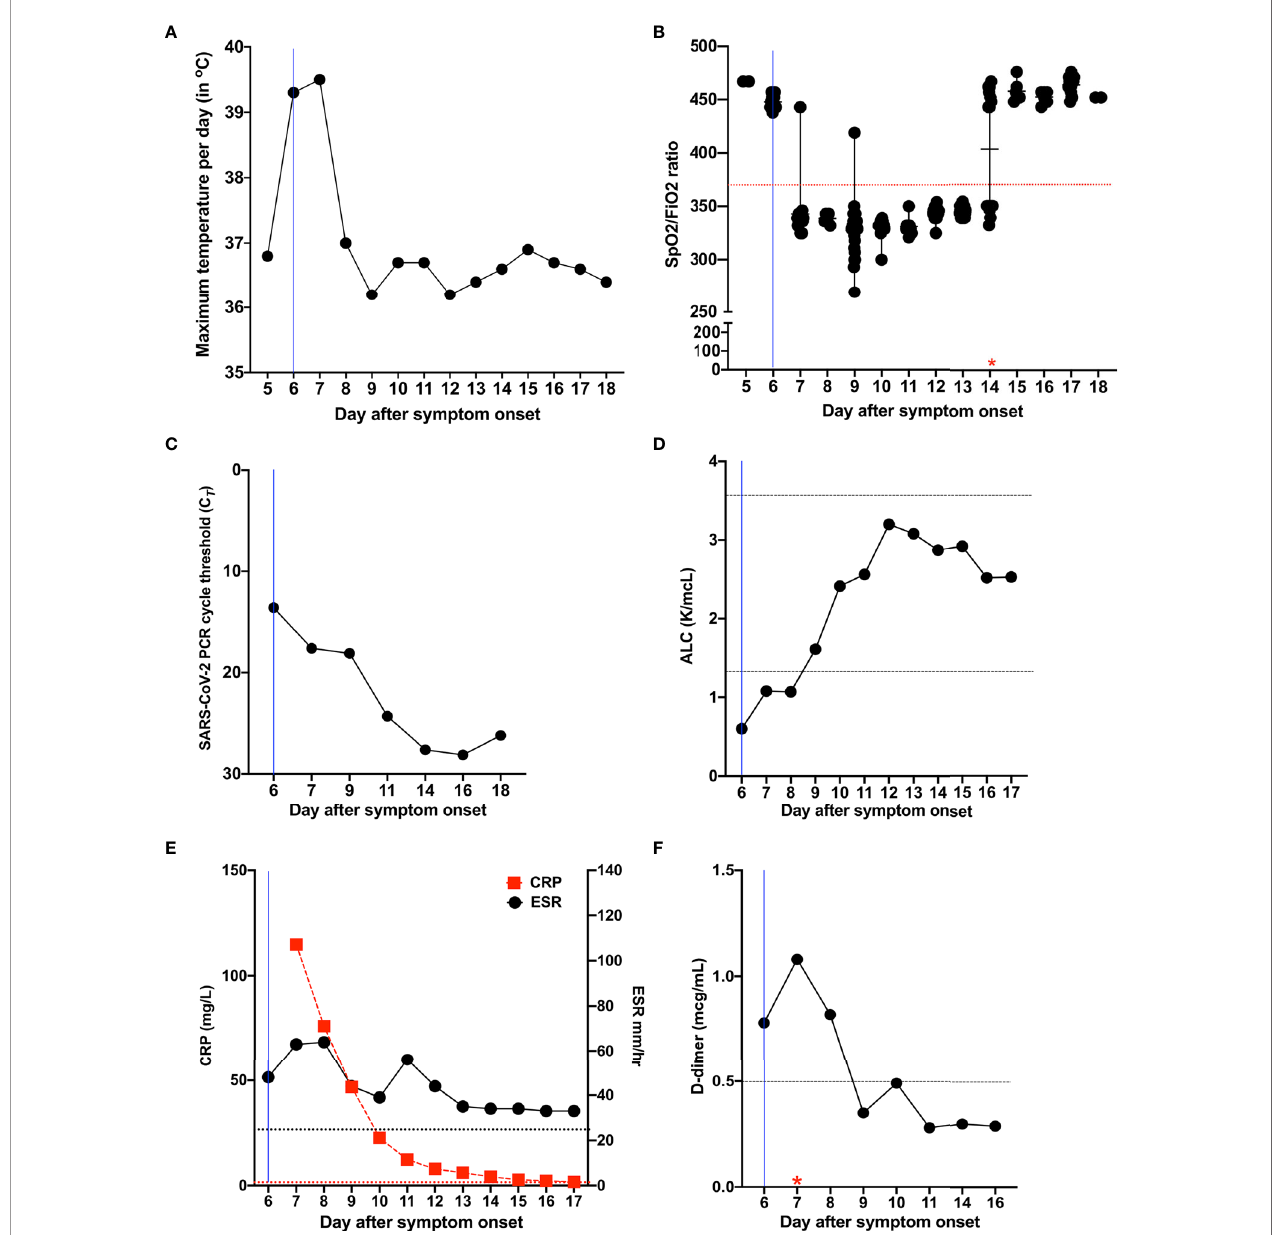
FIGURE 1 | Temporal evolution of clinical and laboratory characteristics in Patient 1 during the course of COVID-19. (A) Temporal evolution of maximum temperature per day in degrees Celsius (°C). (B) Measures of oxygen uptake requirements SpO2/FiO2 [% blood oxygen saturation (SpO2)/fraction of delivered oxygen (FiO2)], a ratio that accounts for both oxygen delivery and uptake (maximum, 476 for 100% oxygen saturation on room air). The red star indicates the day of discontinuation of supplemental oxygen. (C) Temporal evolution of cycle threshold (Ct) of SARS-CoV-2 PCR test results. (D) Temporal evolution of absolute lymphocyte count (normal range, 1.37 to 3.57 K/µl). (E) Temporal evolution of the in fl ammatory markers CRP (red; normal range, < 3 mg/L) and ESR (black; normal range, < 25.0 mm/hr). (F) Temporal evolution of D-dimer (normal range, < 0.5 µg/mL). The red star indicates the day of initiation of anticoagulation. The blue line in all fi gures corresponds to the day when the patient was initiated on methylprednisolone, remdesivir, and bamlanivimab and etesevimab. Horizontal dotted lines indicate normal range. ALC, absolute lymphocyte count; CRP, C-reactive protein; ESR, erythrocyte sedimentation